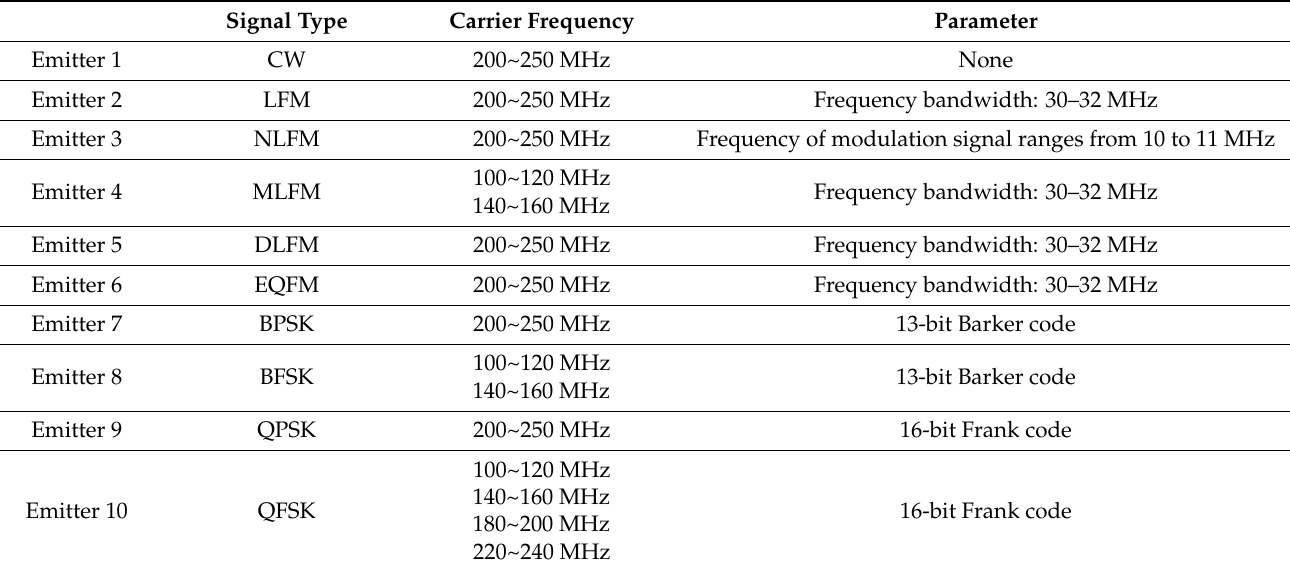
Table 1. Specific parameters of the 14 radar emitter